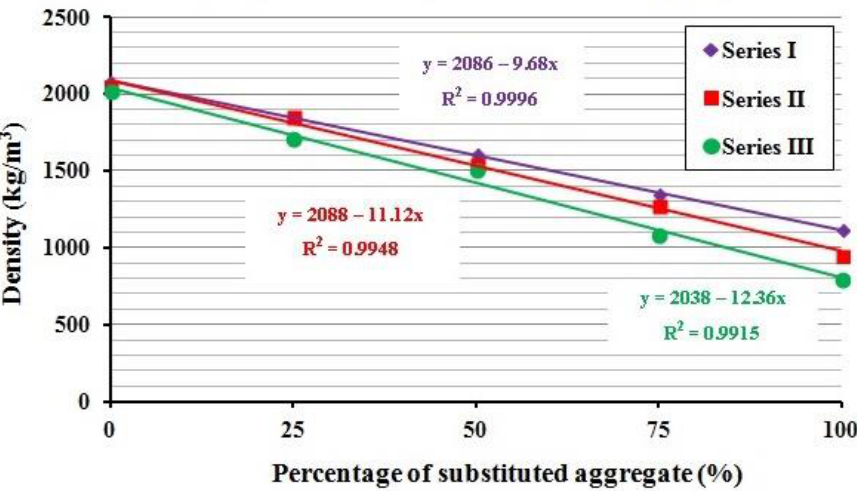
Figure 1. Density vs. percentage of substituted aggregate.